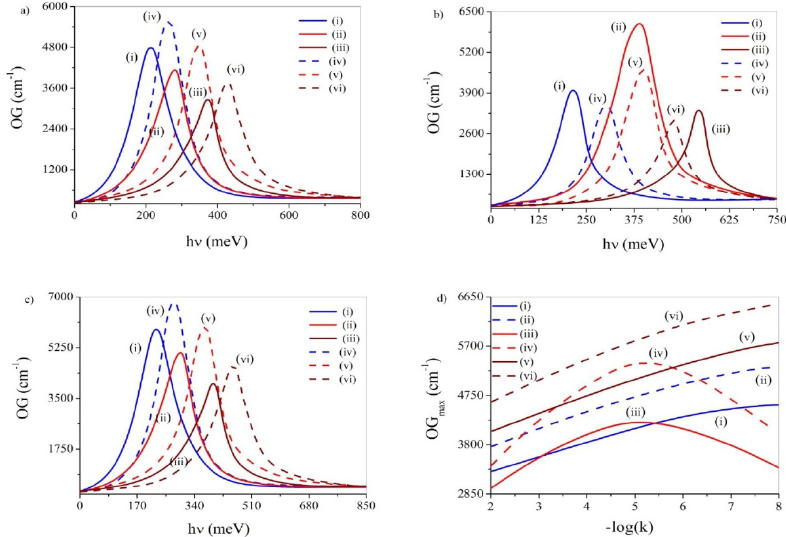
Figure 18. OG vs. h υ diagrams ( a ) devoid of noise, ( b ) under ADWN and ( c ) under MLWN. In these diagrams the anharmonicity has (i) odd parity and k = 10 − 8 , (ii) odd parity and k = 10 − 5 , (iii) odd parity and k = 10 − 2 , (iv) even parity and k = 10 − 8 , (v) even parity and k = 10 − 5 , (vi) even parity and k = 10 − 2 . ( d ) Depiction of OG peak values vs. − log(k): (i) devoid of noise and OPA, (ii) devoid of noise and EPA, (iii) with ADWN and OPA, (iv) with ADWN and EPA, (v) with MLWN and OPA and (vi) with MLWN and EPA. Under applied ADWN, both with OPA and EPA, the OG peaks display blue-shiftas k increases and are accompanied by the emergence of maximization at k ~10 − 5 . Under ap- plied MLWN, both with OPA and EPA, the OG peaks delineate blue-shift with steady decline in the peak altitude with an increase in k . Thus, for a given environment (noise- free/under ADWN/under MLWN), the symmetry of the anharmonicity does not qualita- tively alter the OG profiles.